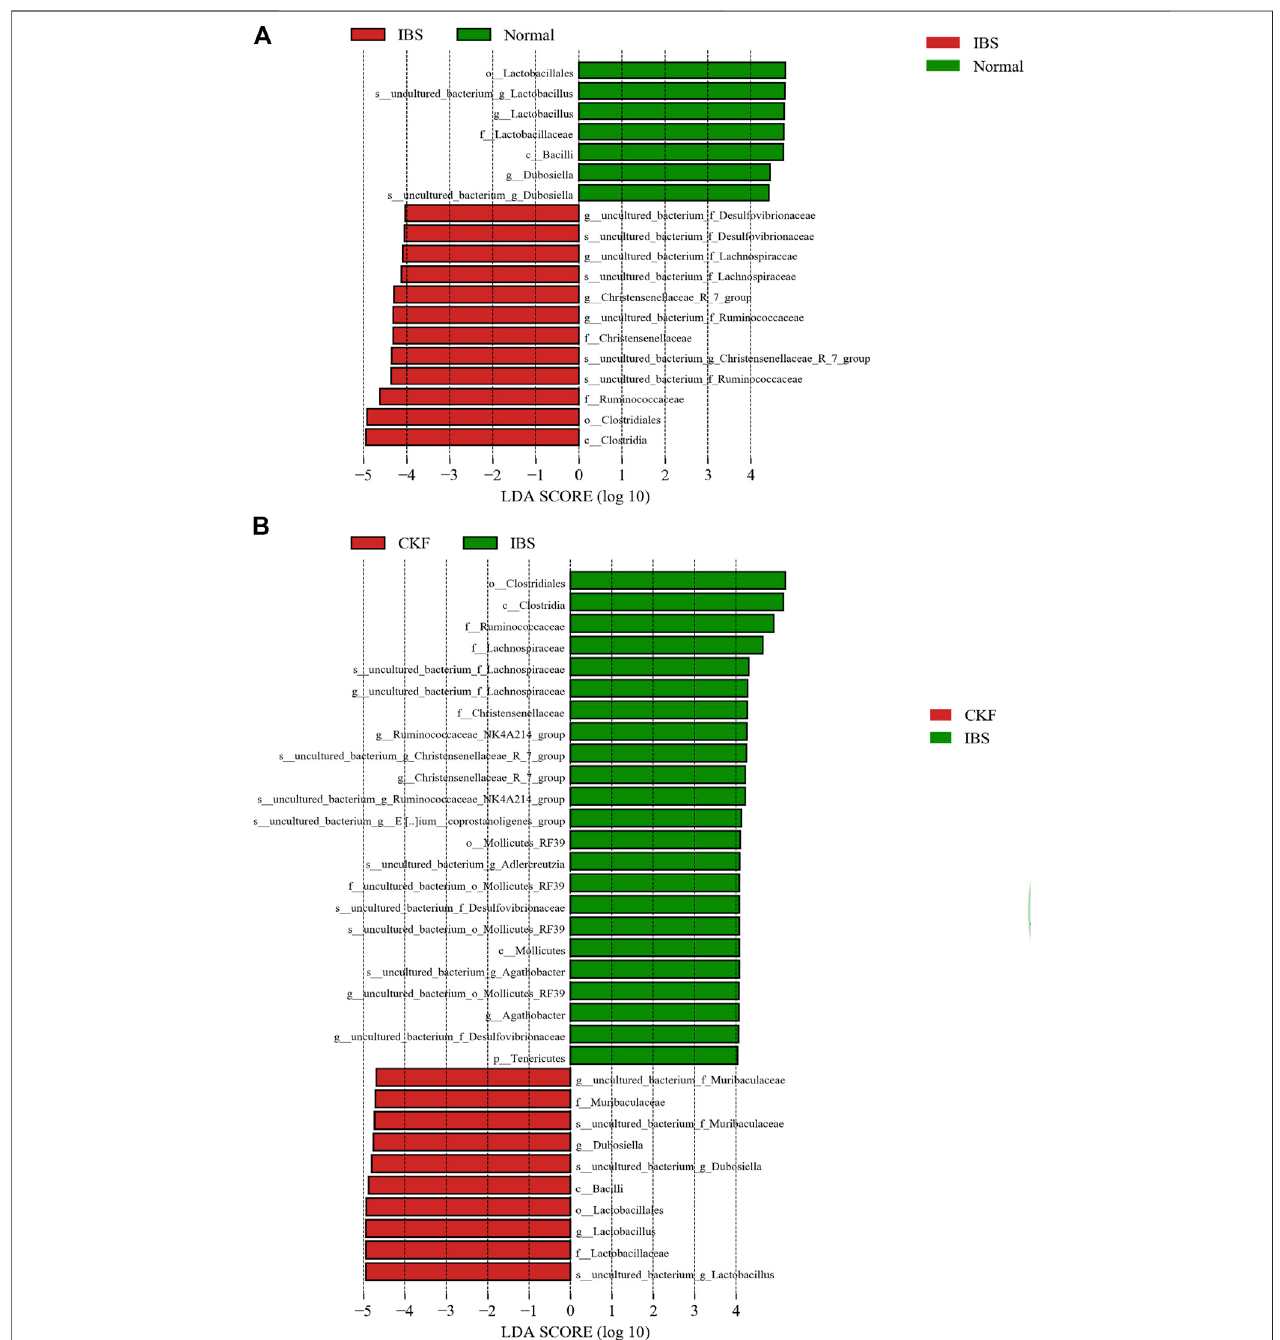
FIGURE8| Lineardiscriminantanalysis(LDA)plotstohighlightthesigni fi cantlydifferentcharacteristictaxonsoncomparingIBSvs.NormalgroupsandCKFvs.IBS groups; only the taxa with a value of LDA score greater than four are shown (A,B) .